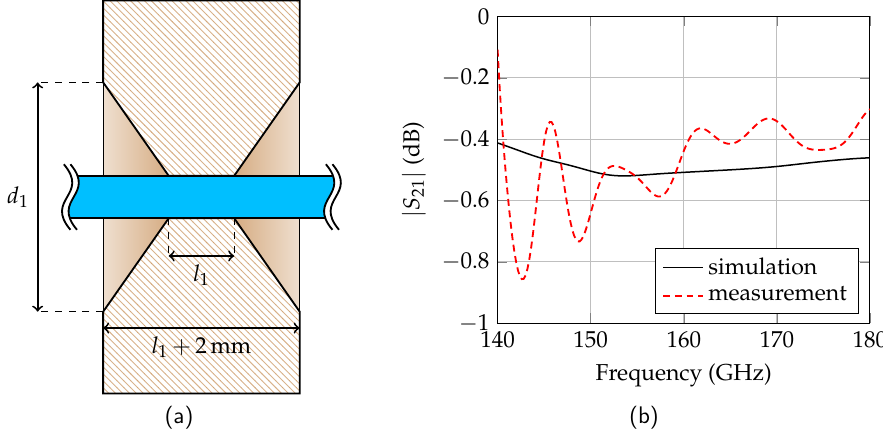
Figure 9. Cross-section of the Rohacell holder with the dielectric waveguide ( a ) and the simulated and measured insertion loss ( b ).